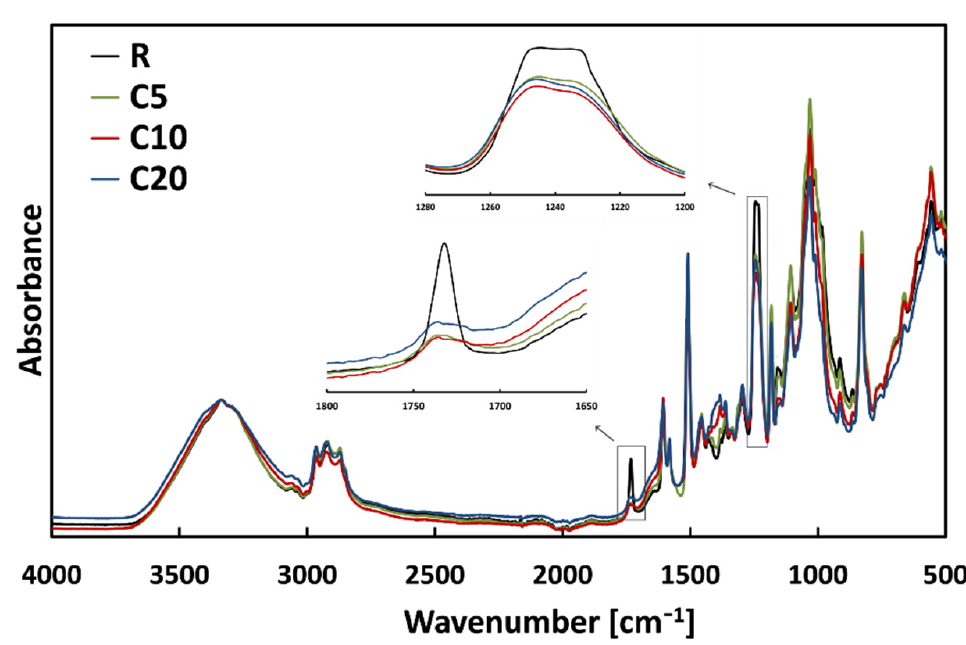
Figure 13. FTIR spectra of untreated and treated flax fibers.